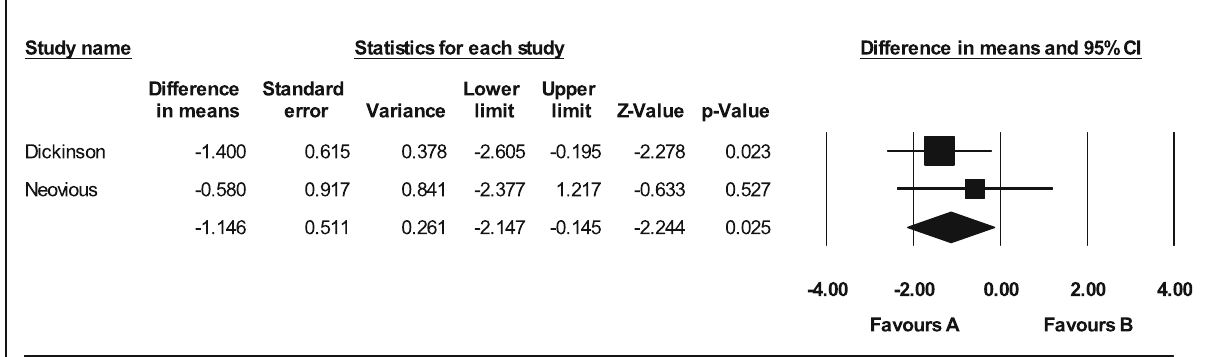
Fig. 7 Comparison of length of hospital stay between autologous bone and rh-BMP2 graft [favors A: autologous bone graft; favors B: alloplastic bone